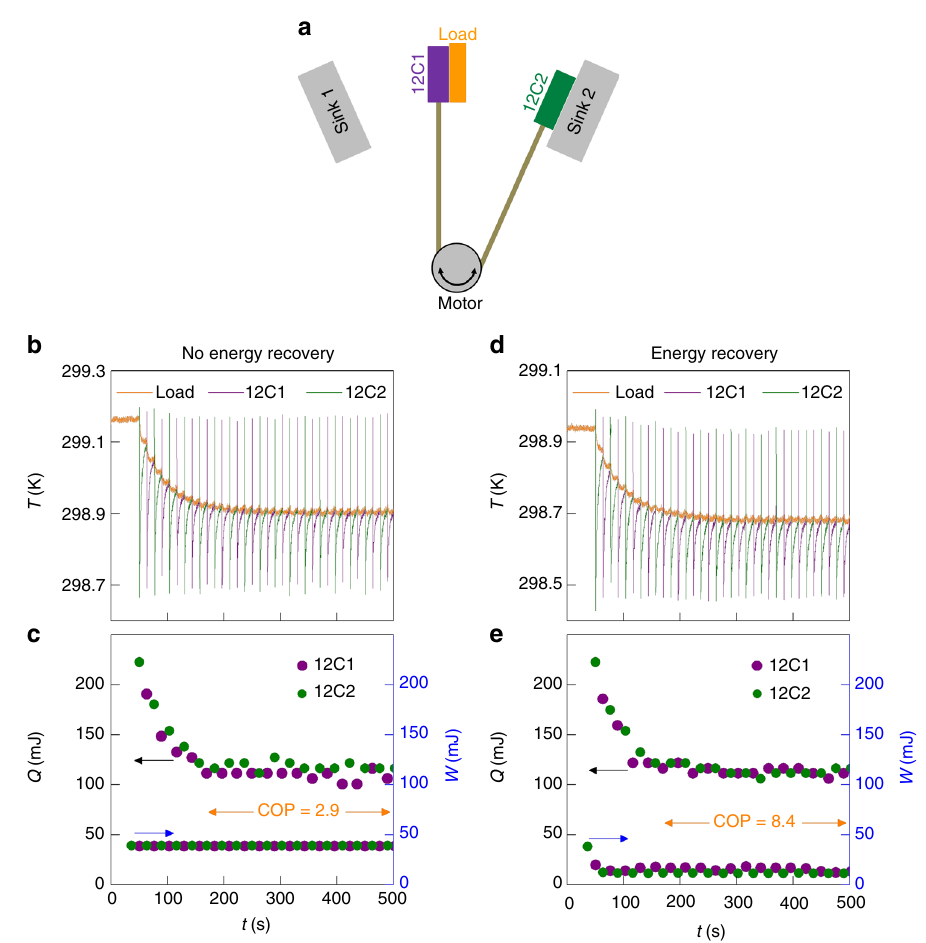
Fig. 5 EC prototype without and with energy recovery. a Device schematic with EC plates 12C1 and 12C2, each based on 12 MLCs. Data are presented ( b , c ) without energy recovery and ( d , e ) with energy recovery. b , d In a given half cycle, each plate (whose temperature is given by the green or purple data) underwent rapid adiabatic EC cooling before slowly absorbing heat from the load, whose temperature T c (orange data) fell by 0.26 K with respect to starting temperature T h on reaching the steady state around 250s after start-up at time t = 40 s. c , e For each half cycle, we show the heat Q absorbed by the cold plate from the load, and the work W done to charge the other plate back to 70 V at the sink (where it thus dumps